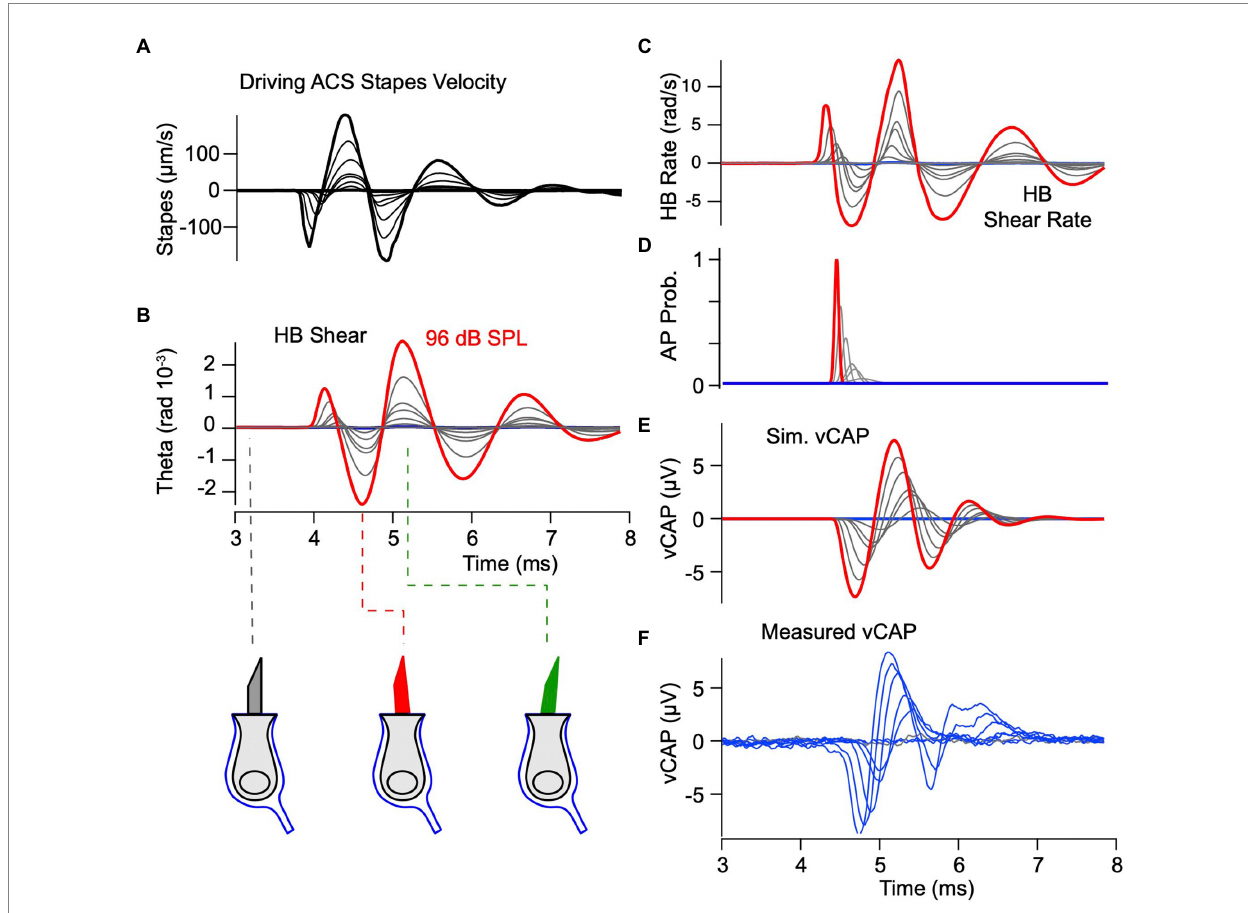
FIGURE 6 vCAP evoked by ACS. Theory vs. Experiment. Model parameters are exactly the same as previous figures, and the format is the same as Figure 5. (A) Experimentally measured vibration of the stapes used as the input to the simulations. (B,C) Simulated shear and shear rate activating hair bundles. (D) Probability of evoking a spike as a function of time. (E,F) Simulated and experimentally measured